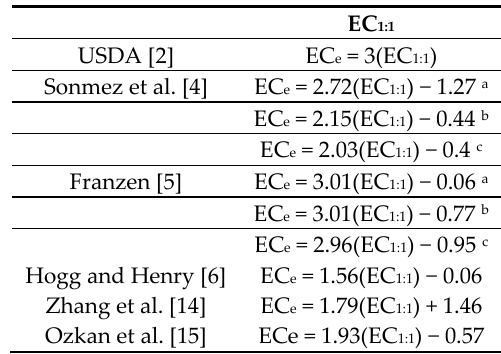
Table 1. The EC e = f (EC 1:1 ) relationship proposed by several researchers. The indices a , b , c refer to coarse, medium and fine soils respectively.